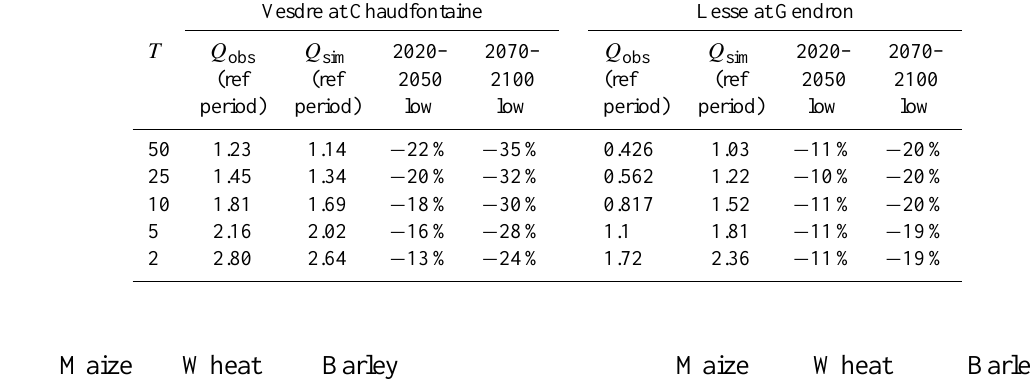
Table 3. Comparison between observed and simulated MAM7 during reference period and changes in MAM7 values for the Vesdre at Chaudfontaine (left) and the Lesse at Gendron (right) for different return periods ( T ). Vesdre at Chaudfontaine